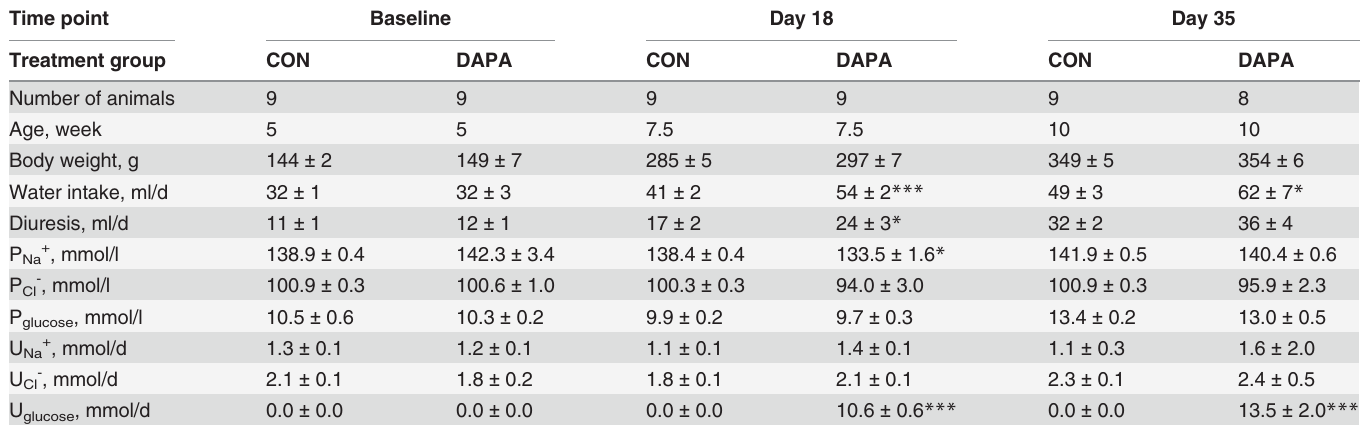
Table 2. Effect of DAPA on body weight, fluid balance and electrolytes in normal SD rats. Time point